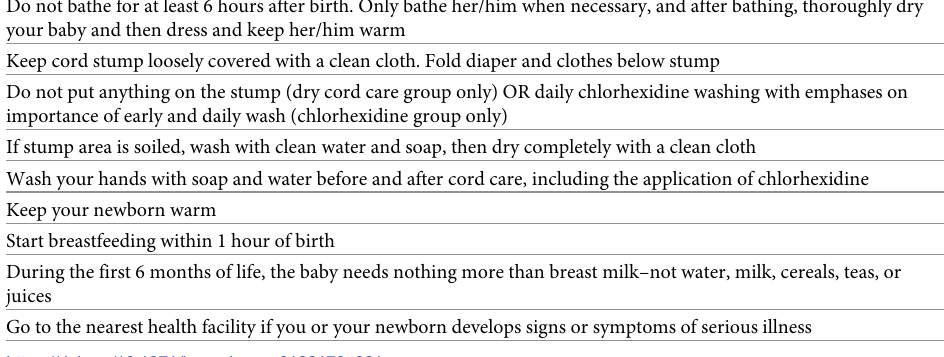
Table 1. ZamCAT newborn health